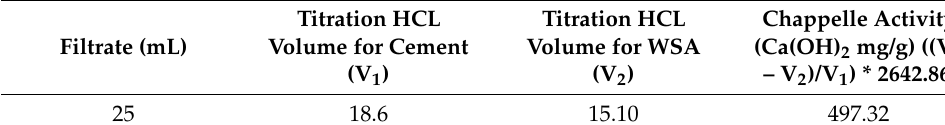
Figure 4. X-ray diffraction of wheat straw ash. Table 3. Chapelle activity in WSA and cement.